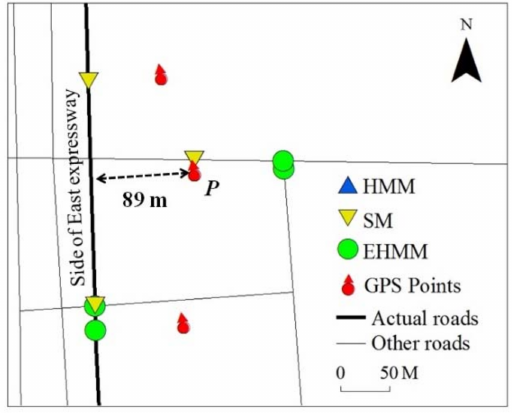
Figure 12. Challenges of MM for models on parallel